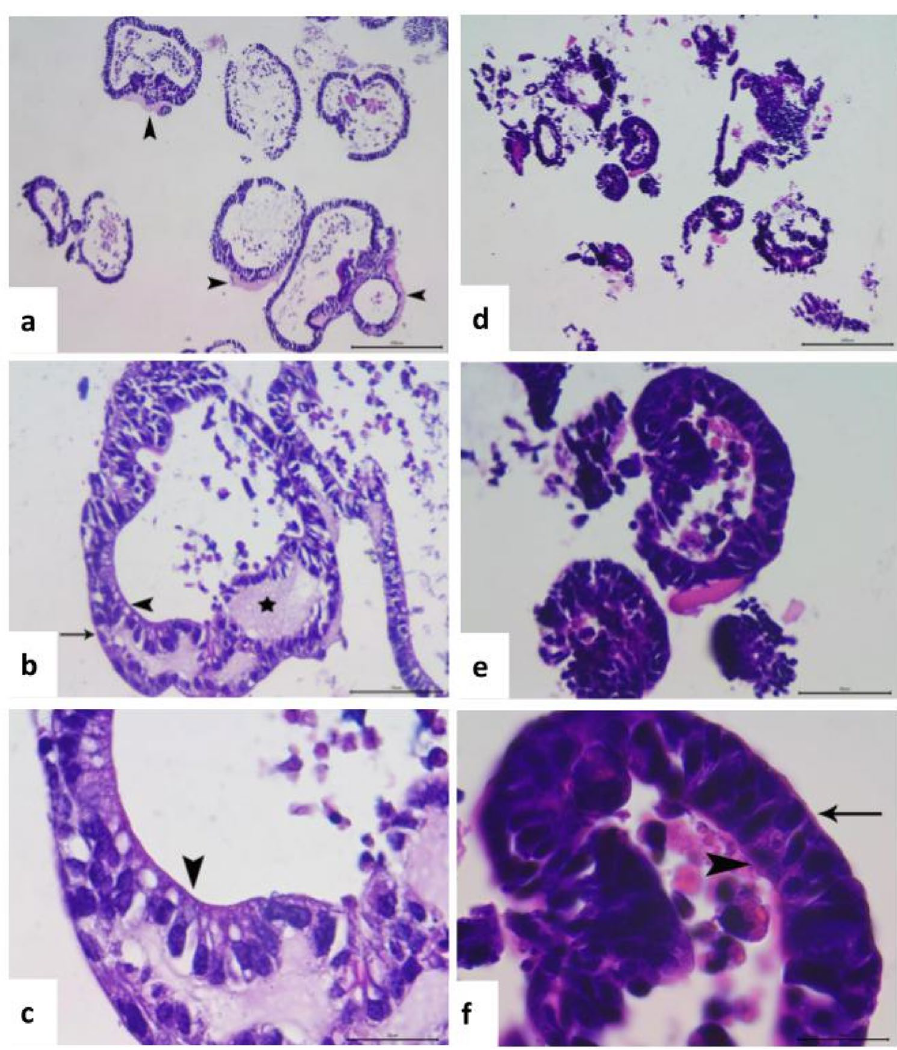
Figure 2. Histological analysis of NF-κB reporter intestinal organoids. Colon-derived ( a – c ) and jejunum- derived ( d – f ) organoids. ( a ) Cluster of colonoids of several sizes. Multiple epithelial ductal structures (columnar epithelium), associated by amorphous eosinophilic matrix (arrowhead). Hematoxylin–eosin staining (HE), 10×. Bar = 200 µm. ( b ) Colonoid epithelial duct showing different cell types described. Columnar epithelium organized from the subtle eosinophilic extracellular matrix (arrow), with amorphous and diffusely vacuolated eosinophilic material (asterisk), presence of some goblet-like cells in the luminal ductal surface were typical (arrowhead). HE, 40×. Bar = 50 µm. ( c ) High magnification of ( b ), showing epithelial cells (typical rounded and intense basophilic nuclei), interspersed with goblet-like cells with vacuoles in the luminal ductal surface (arrowhead). HE, 100×. Bar = 20 µm. ( d ) Cluster of jejunum-derived organoids of several sizes. Multiple epithelial ductal structures (columnar epithelium).HE, 10×. Bar = 200 µm. ( e ) Epithelial ducts showing similar cell types described in ( b ), with detachment of necroapoptotic cells in the ductal lumen. HE, 40×. Bar = 50 µm. ( f ) High magnification of ( b ), showing epithelial cells organized from the basal extracellular matrix (arrow), with less abundant goblet-like cells (arrowhead). HE, 100×. Bar = 20